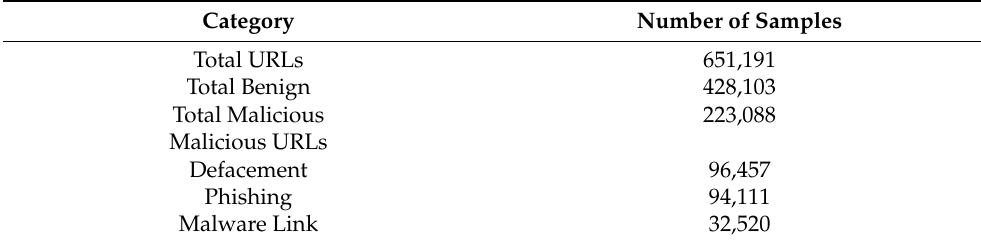
Table 1. Number and types of URLs used in this